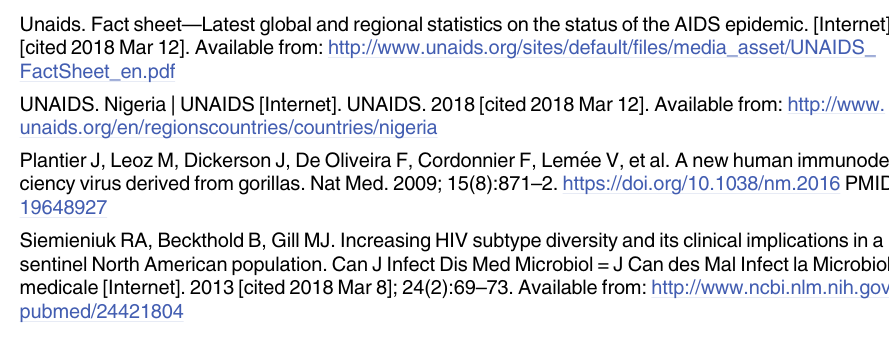
S1 Fig. Study profile showing number of participants included in analysis at each time